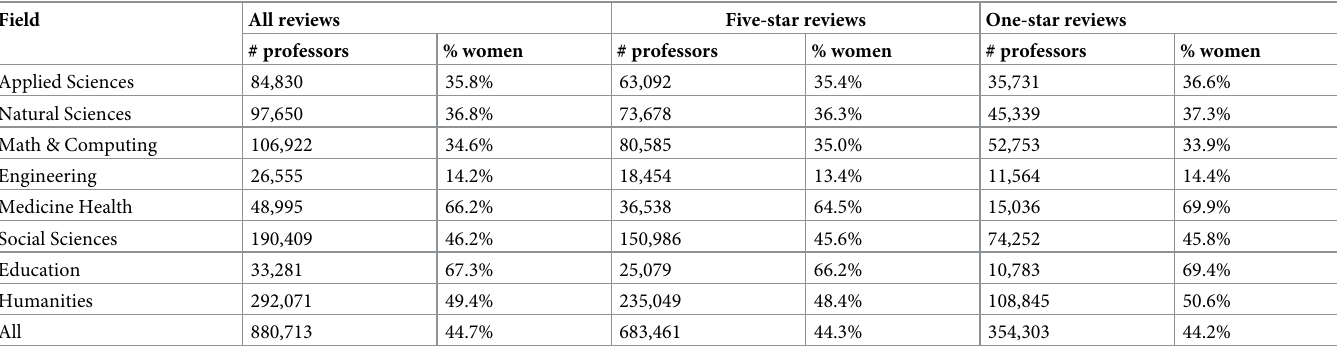
Table 1. The distribution of professors and share of women by